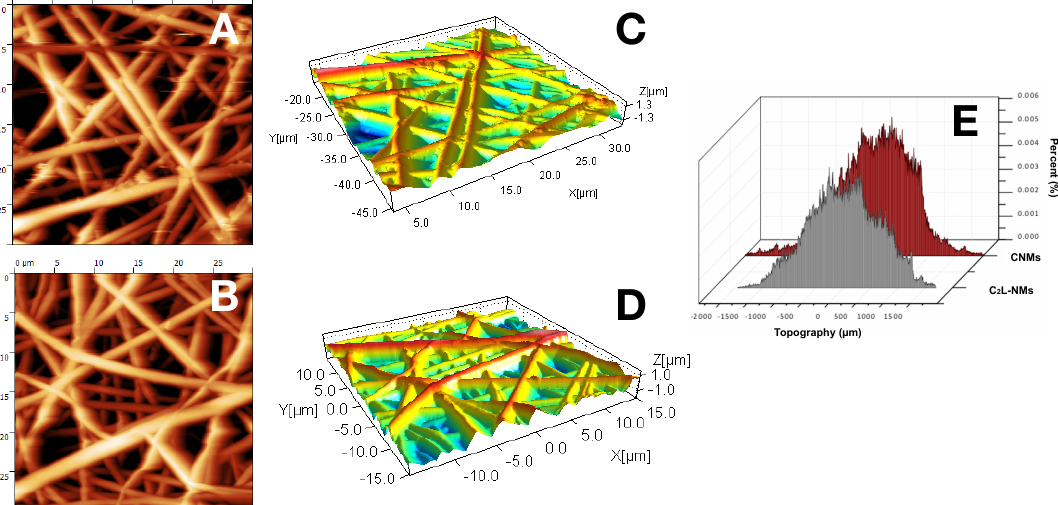
Figure 2. AFM micrographs of 30 × 30 µm scanned areas of PCL/PHB NMs before the incubation with duckweed plants: ( A ) control NMs (CNMs); ( B ) NMs loading higher C 2 catechol concentration (C 2 L-NMs); ( C , D ) 3D-plot of images of A and B ; ( E ) roughness analysis reporting the percent distribution of peaks and depths in the topography (µm) of the scanned areas of the NMs shown in C and D (positive and negative values of the distribution, respectively).